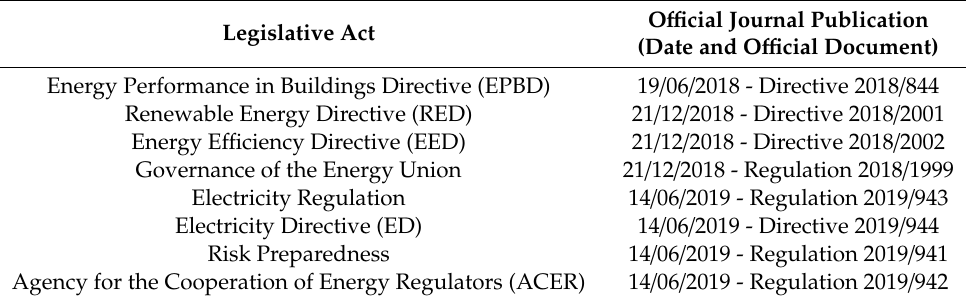
Table 1. Overview of the eight legislative acts combined in the Clean Energy for all Europeans package (adopted from